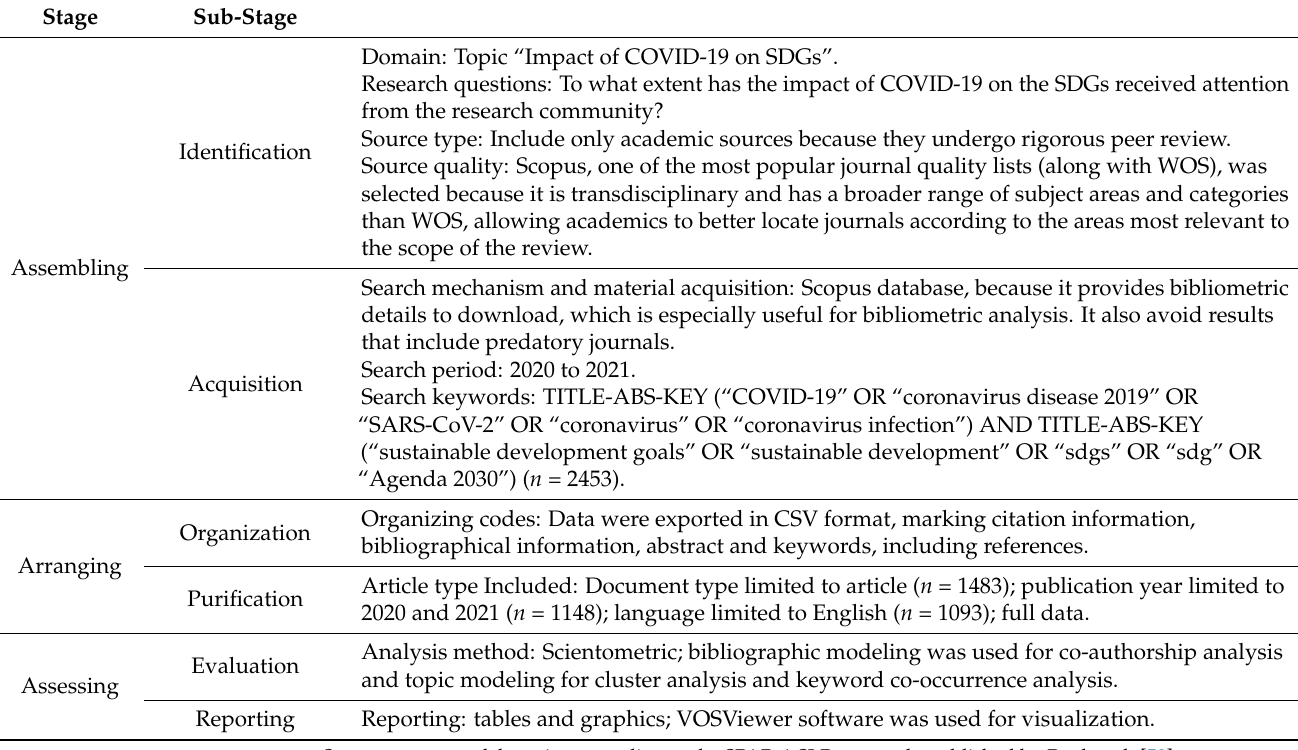
Table 1. Summary for SPAR-4-SLR protocol